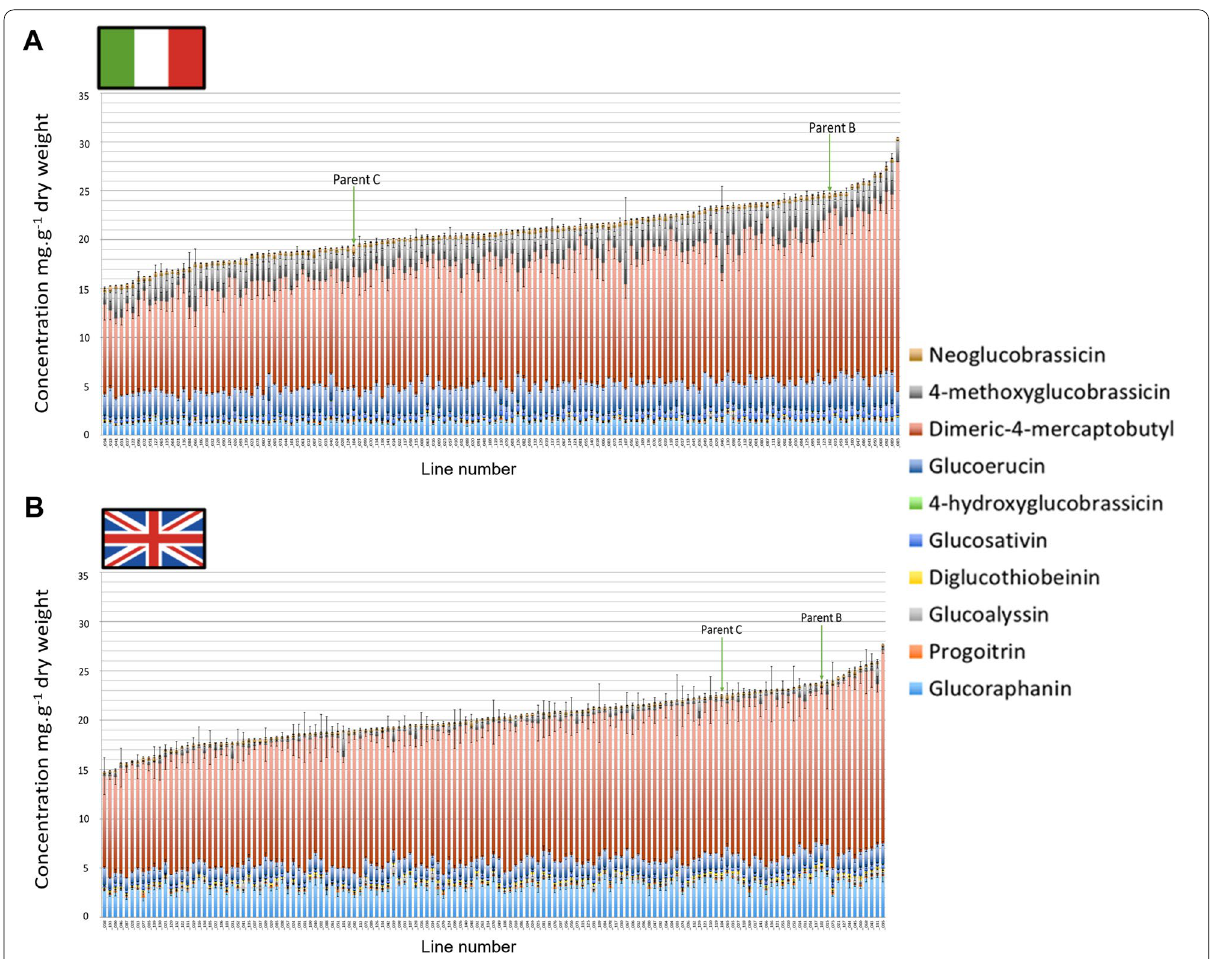
Fig. 2 Glucosinolate compositions and concentrations (mg g − 1 dry weight) of 139 F 4 Eruca vesicaria subsp. sativa mapping population lines and their parental lines B and C cultivated in Italy ( A ) and the United Kingdom ( B ). Lines are ordered along the x-axis according to total glucosinolate